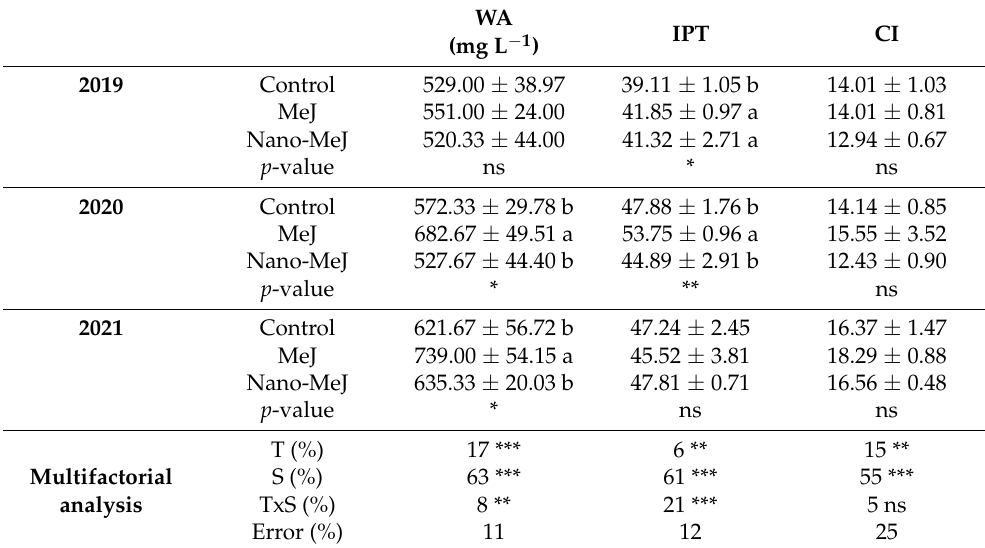
Table 4. Wine spectrophotometric variables from control and different treatments (MeJ and nano-MeJ). WA